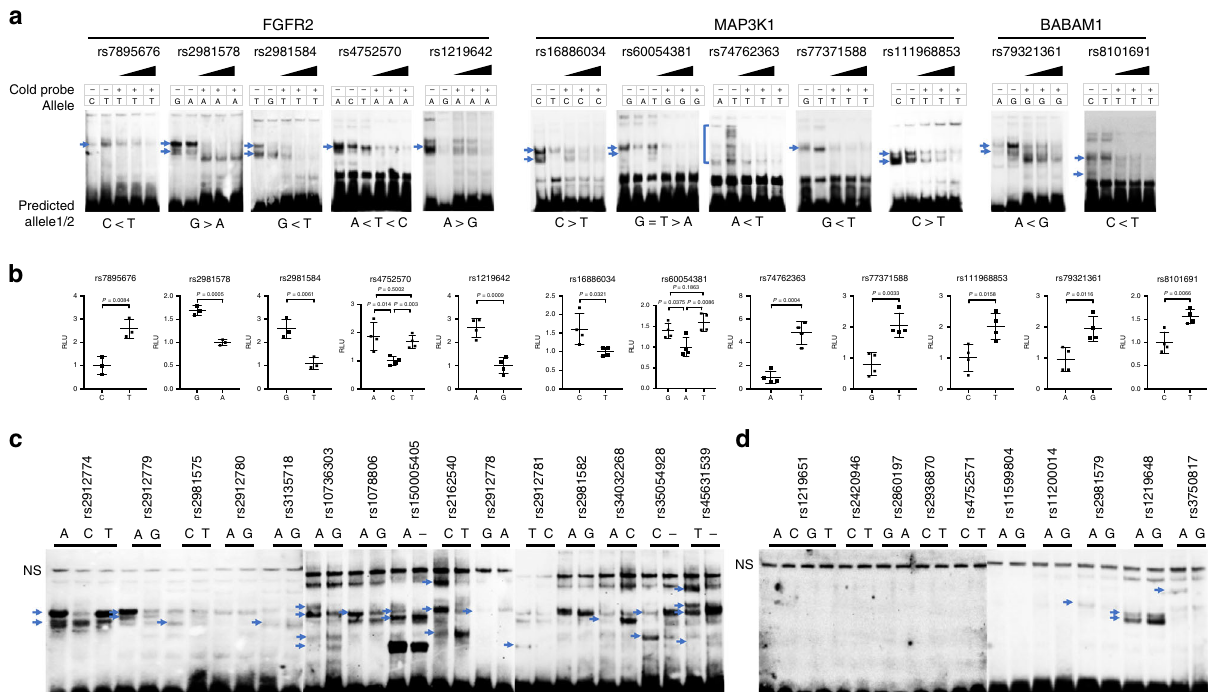
Fig. 3 Demonstration of fSNPs by EMSA and luciferase reporter assay. a EMSA showing allele-imbalanced gel shifting for fi ve candidate fSNPs on the FGFR2 locus (left), fi ve on the MAP3K1 locus (middle) and two on the BABAM1 locus (right) with P value < 0.05; − 0.05 > Slope > 0.05. Also, same EMSA showing the allele-imbalanced shifted bands are competed away by cold probe with a concentration of 2, 4 and 6 µ g in each assay. Predicted allele1/2: predicted allele-imbalanced gel shifting with the direction between the two alleles based on the data from Reel-seq screen. The data represent three biological independent experiments ( n = 3). b Luciferase reporter assays showing allele-imbalanced luciferase activity for each SNP. The data for rs7895676, rs2981578, and rs2981584 represent three biological independent samples ( n = 3); the data for the other nine SNPs represent four biological independent samples ( n = 4). P value was calculated using Student ’ s t test with two tails. Error bars represent the median with SE. c EMSA showing allele- imbalanced gel shift results for 13 of the 15 putative fSNPs ( P value < 0.05) on the FGFR2 locus. The data represent three biological experiments ( n = 3). d EMSA showing allele-imbalanced gel shift pattern on three of the ten non-fSNPs ( P value > 0.05) on the FGFR2 locus. The data represent three biological experiments ( n = 3). P value was calculated using Student ’ s t test with two tails. Error bars in all the plots represent the median with SE. NS nonspeci fi c gel shift, RLU relative luminescence unit. Blue arrows indicating the allele-imbalanced gel shift pattern. Source data are available in the Source Data fi